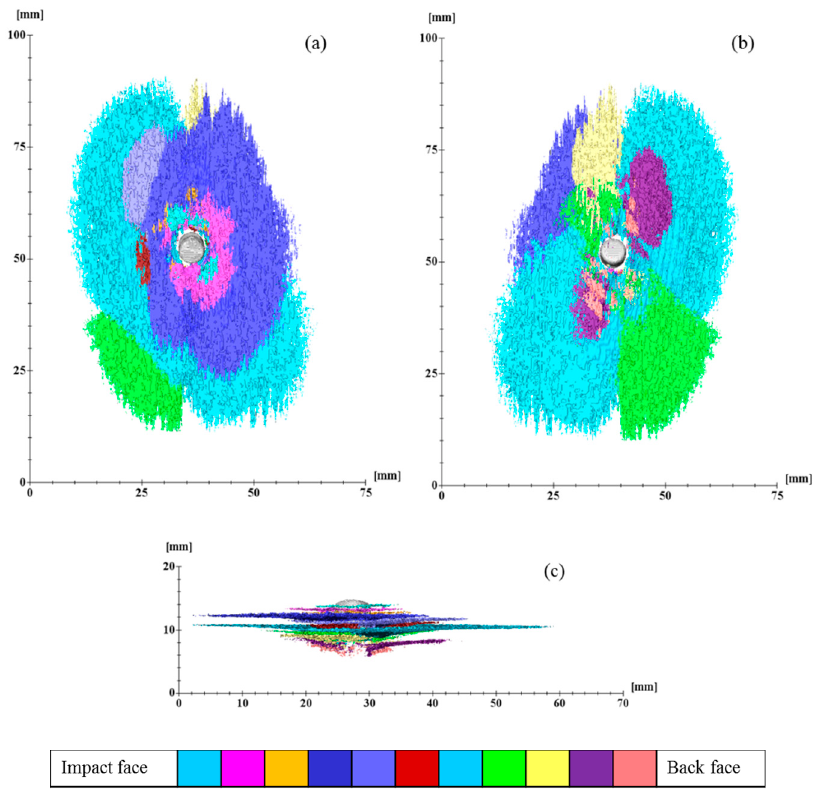
Figure 9. Delamination volume of P17C at different positions: ( a ) View from impact face; ( b ) View from back face; and ( c ) Cross-sectional view.